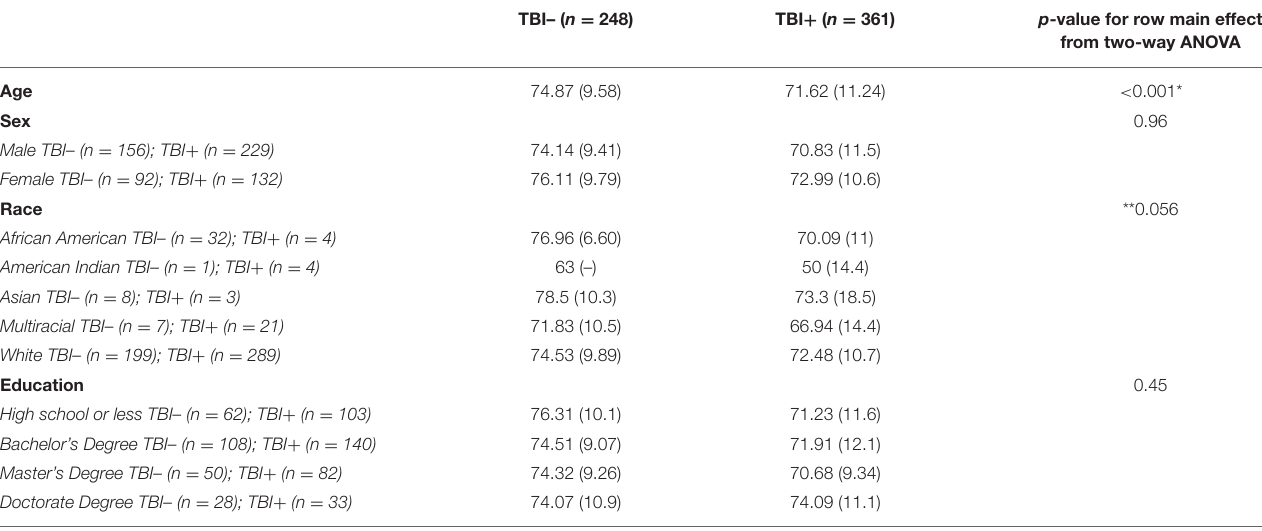
TABLE 1 | Demographic data at the time of the first cognitive decline assessment.